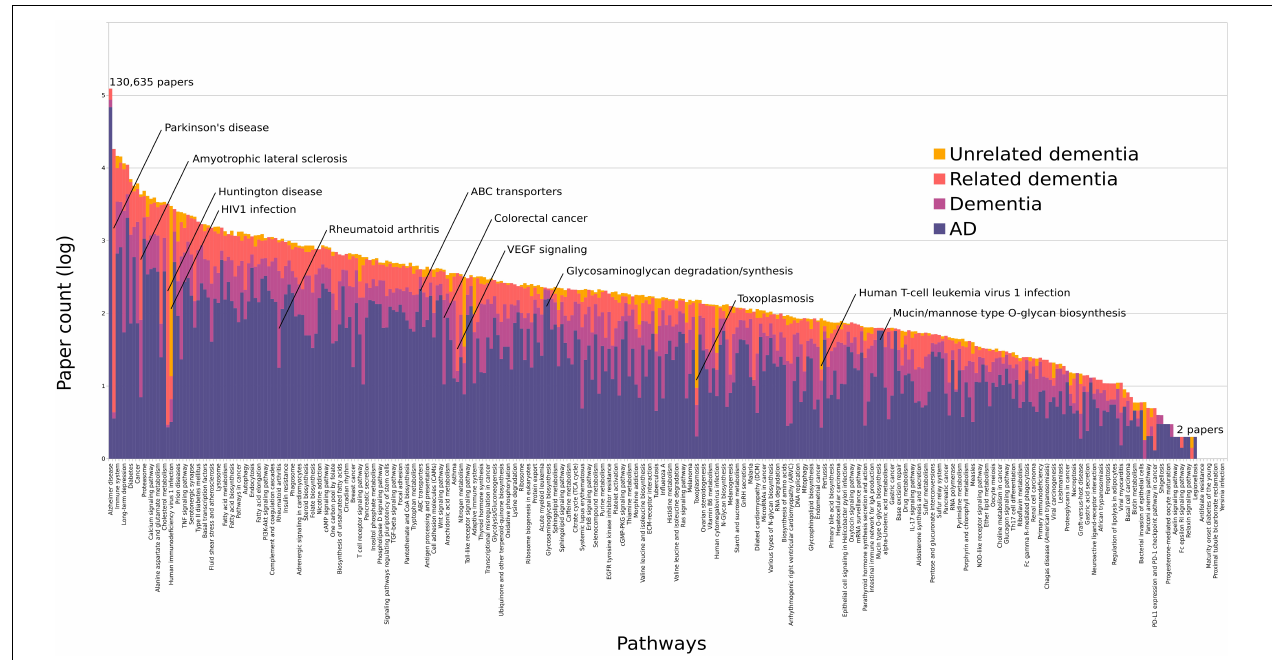
FIGURE 2 | All pathways ordered by the log of their total paper counts associating them with AD or dementia. We have colored each bar to represent the percentage of papers containing an adequate number of AD-relevant words (purple), dementia terms (pink), dementia caused by related disorders (orange), and unrelated dementias (yellow). Pathways with only 1 study do not display on this scale. The average percentage of AD-specific studies per pathway was 64% excluding those with less than 50 studies. The highest proportions were found in ABC transporters (88%), Alzheimer’s disease (95%), the glycosaminoglycan pathways (93–94%), and the O-glycan pathways (98%). These data are summarized in Supplementary Table 4